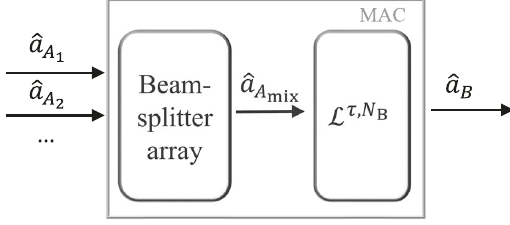
Fig. 3 Schematic of the bosonic thermal-loss MAC. The beam splitter array models a linear scattering medium. The thermal-loss channel models the noisy